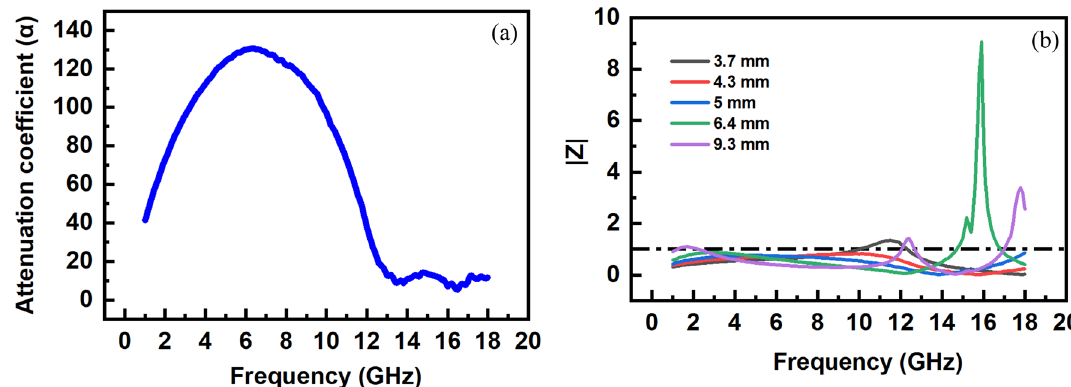
Figure 11. ( a ) Attenuation values versus frequency, and ( b ) normalized impedance versus frequency and